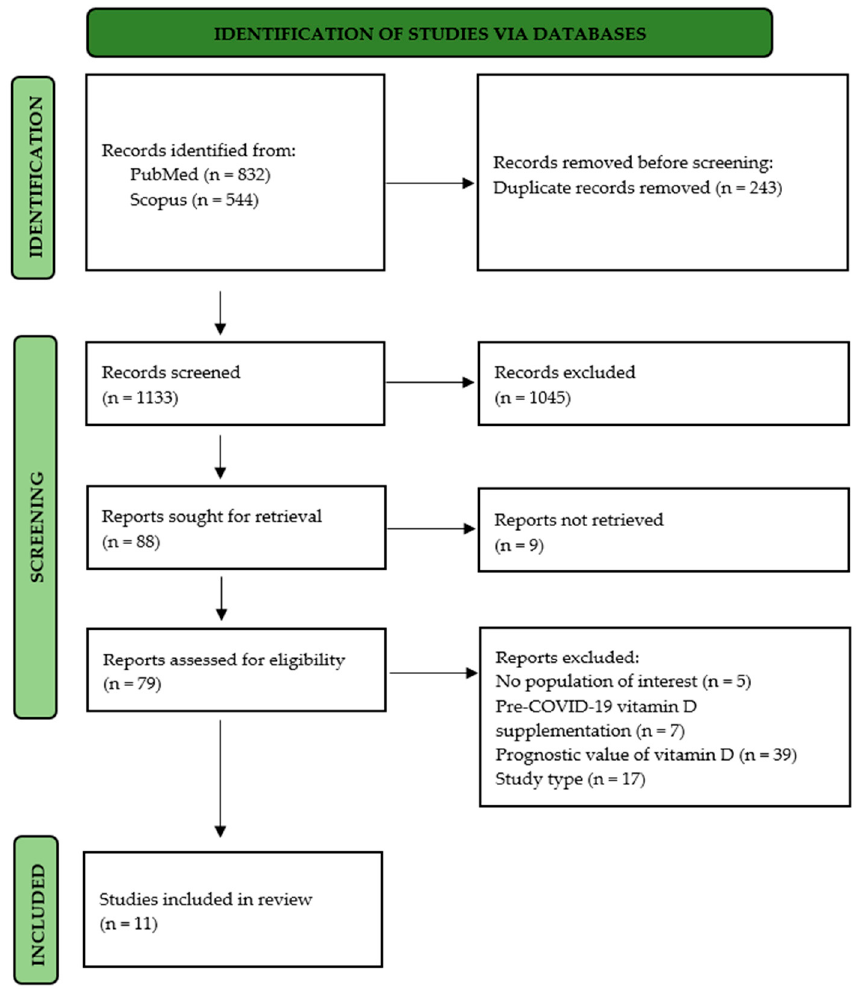
Figure 1. PRISMA flow diagram.